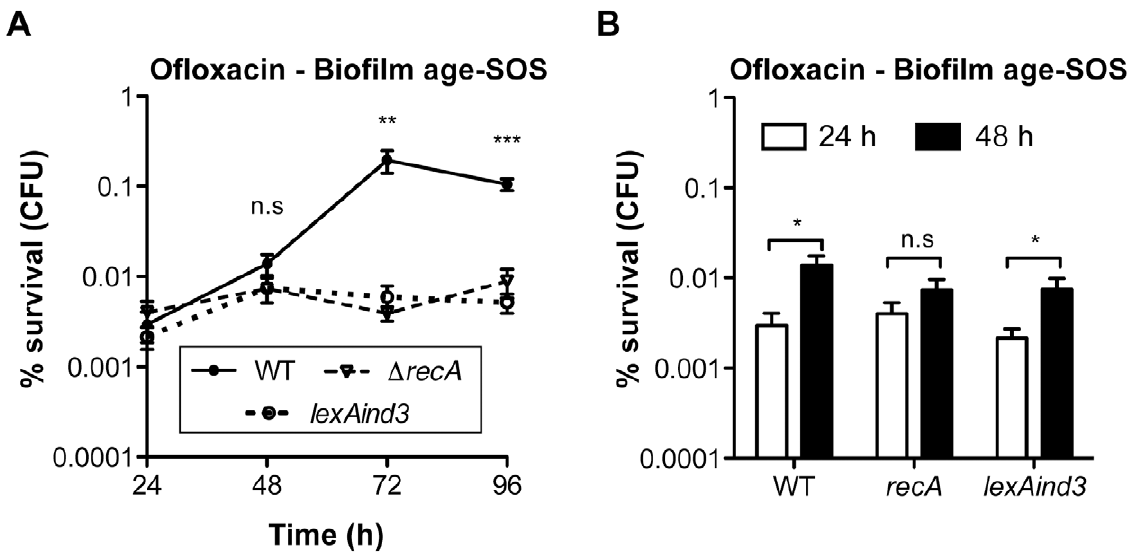
Figure 6. Ofloxacin tolerance in aging biofilms is SOS-response-dependent. (A) The influence of the SOS response on the ofloxacin tolerance of aging biofilms was evaluated and compared between biofilms of wild-type TG1 (WT), D recA , and lexAind3 . (B) A close-up of the data obtained in panel A for the 24- and 48-h biofilms. Briefly, all biofilms were grown for 24, 48, 72 and 96 h in M63B1 Gluc with medium renewal every 24 h and treated for 24 h with ofloxacin (5 m g ml 2 1 , 80 6 MIC) in M63B1 Gluc (no starvation). Survivors were quantified by viable cell counts. Percent survival represents the tolerant population after 24 h of treatment compared to untreated biofilm prior to addition of antibiotics. All compared biofilms had similar numbers of CFUs prior to antibiotic treatment (data not shown). Data represented are mean 6 SEM of at least three replicates. Asterisks indicate values significantly different than WT (panel A). Statistics were performed by the two-tailed unpaired t-test: * P # 0.05, ** P # 0.01, *** P # 0.0001, and n.s. (not significant). The genotypes of the different strains used are detailed in Table S1 or as follows: WT (TG1), D recA (TG1 D recA ::KmFRT ), and lexAind3 (TG1 lexAind3 ).